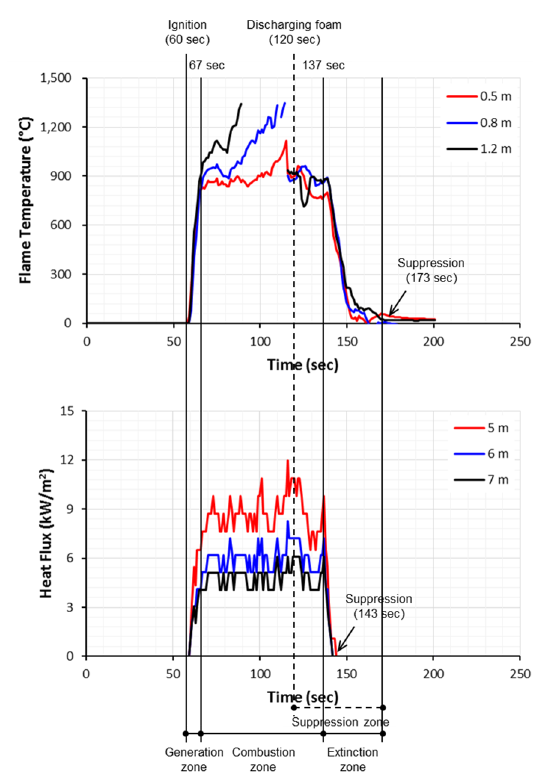
Figure 9. Measured results of specimen III for the flame temperature and the heat flux in accordance with the measured distance.